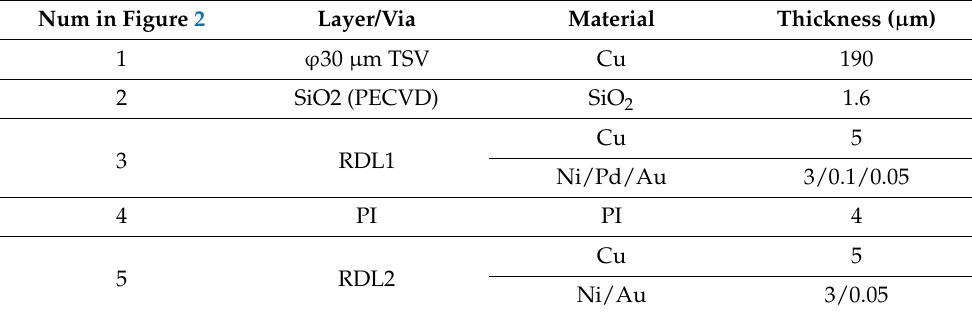
Table 1. Process parameters of the bottom interposer wafer.